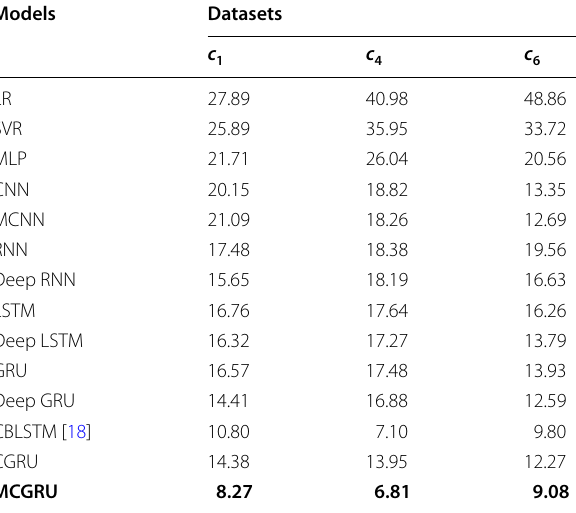
Table 6 RMSE of all the models in the first experimental case Models